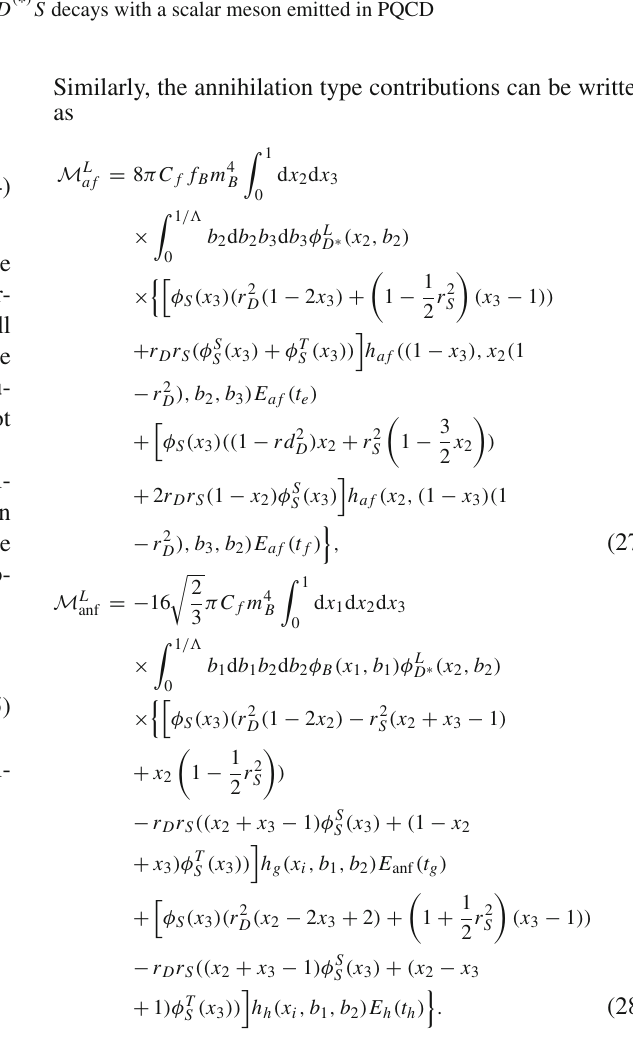
Fig. 2 Leading order Feynman diagrams contributing to the B → D